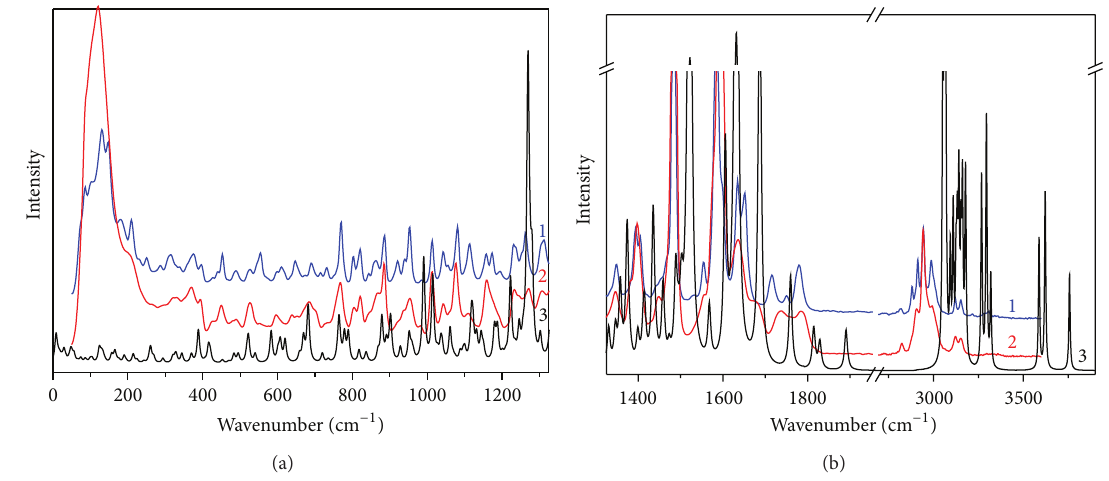
Figure 4: Raman scattering spectra of cefuroxime axetil at room temperature, in polycrystalline powder: (1) crystalline form and (2) amorphous form. The corresponding calculated IR absorption spectra (B3LYP/6-31G(d,p)) were added for comparison